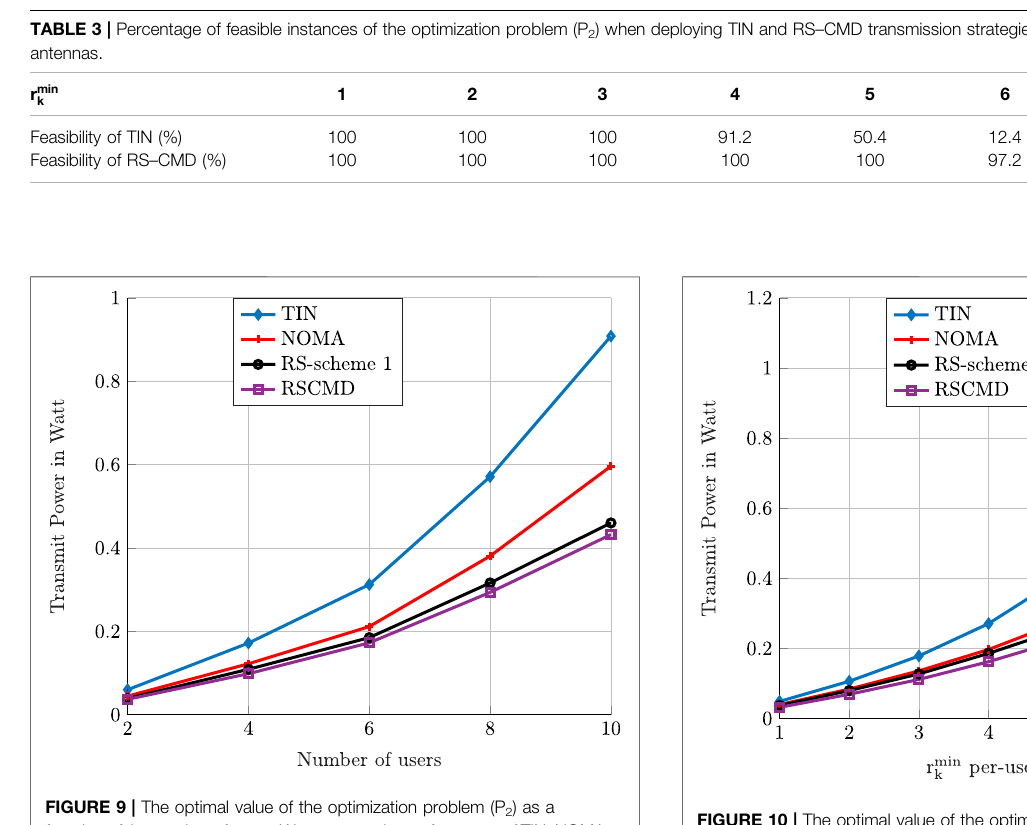
FIGURE 10 | The optimal value of the optimization problem (P 2 ) as a function of the minimum ergodic rate requested by users. We compare the performance of TIN, NOMA, RS-scheme 1, and RS – CMD transmission strategies. Each BS has two